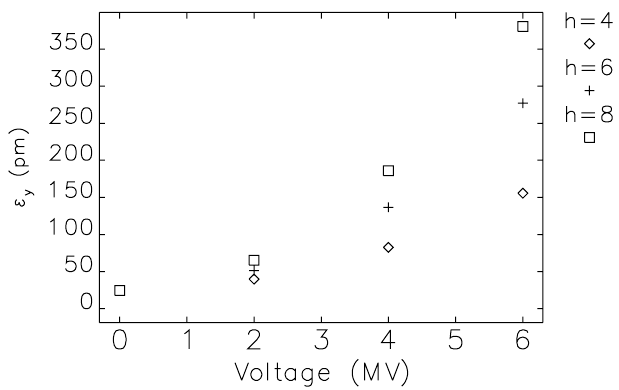
FIG. 14. Vertical emittance as a function of deflecting voltage for various harmonic numbers, with interior sextupoles off and including synchrotron radiation effects.